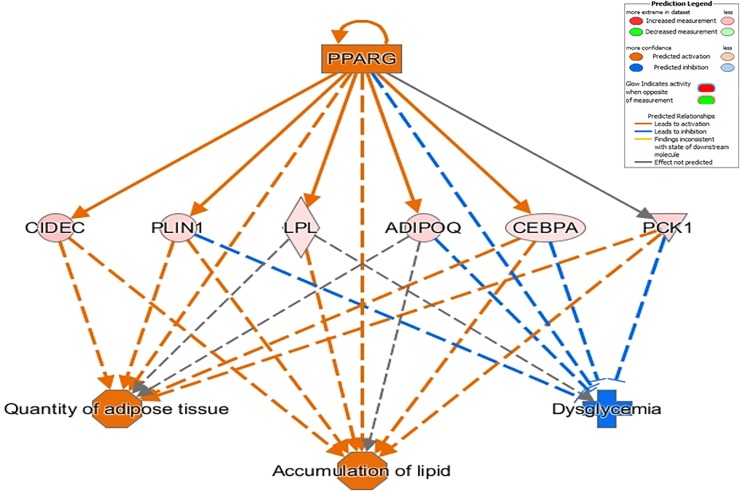
Top-scoring network of regulator effects activated in Iberian HBW fetuses.Upper tier: one upstream regulator is predicted to be activated (orange). Middle tier: gene expression changes in response to activation of upstream regulators (red = upregulated in large fetuses). The shapes of the nodes reflect the functional class of each gene product: horizontal ellipse, transcriptional regulator; vertical rhombus, enzyme; inverted triangle, kinase; and circle, complex/group/other. Direct interactions are represented by solid lines, while indirect interactions are represented by dashed lines. Orange lines lead to activation, while blue lines lead to inhibition. Lower tier: expected phenotypic consequences of gene expression changes based on data in the Ingenuity Knowledge Base (absolute z-score > 2 and p < 0.05). The octagonal symbol defines function.